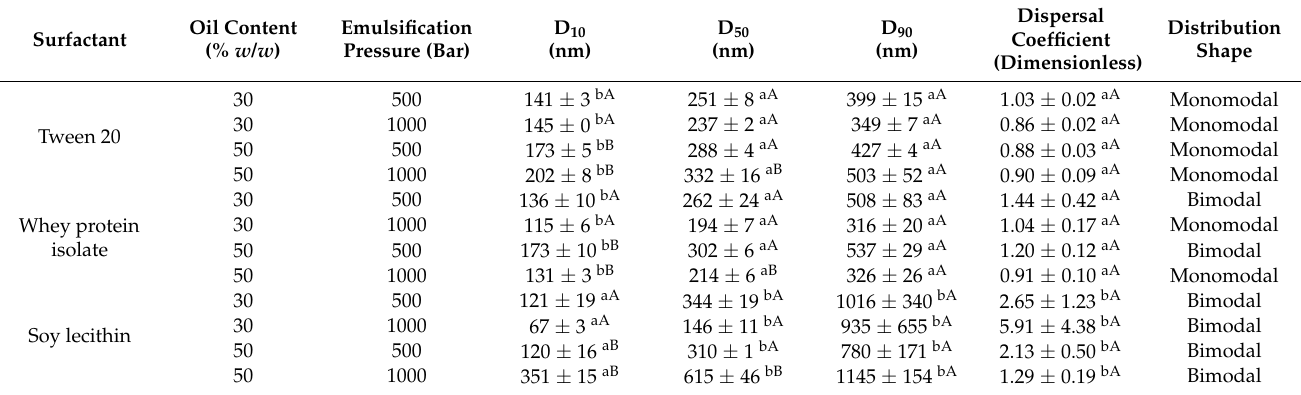
Table 2. Droplet diameter and dispersal coefficient obtained from the cumulative frequency distributions of oil droplet size for the three surfactants studied. 1